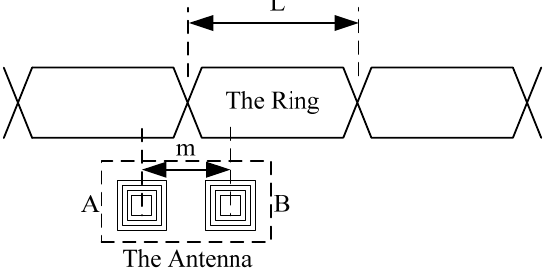
Figure 4. The relative position between the coils and the ring as the two coils produce voltage with the opposite phase.